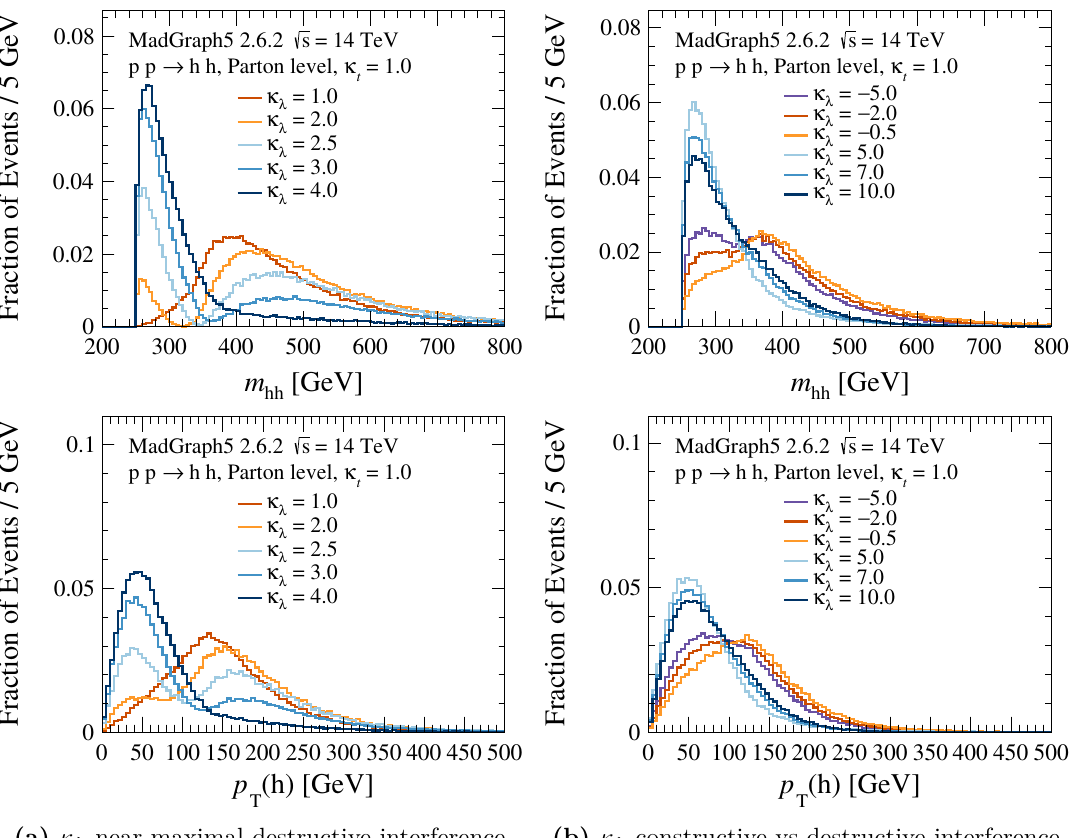
Figure 3. Unit normalised distributions of the (upper) di-Higgs invariant mass m hh and (lower) Higgs transverse momentum p T ( h ) at parton level. The κ λ values highlight differential effects (a) around the point of maximal destructive interference κ λ ’ 2 . 5 and (b) of constructive vs destructive interference arising from the sign of κ λ